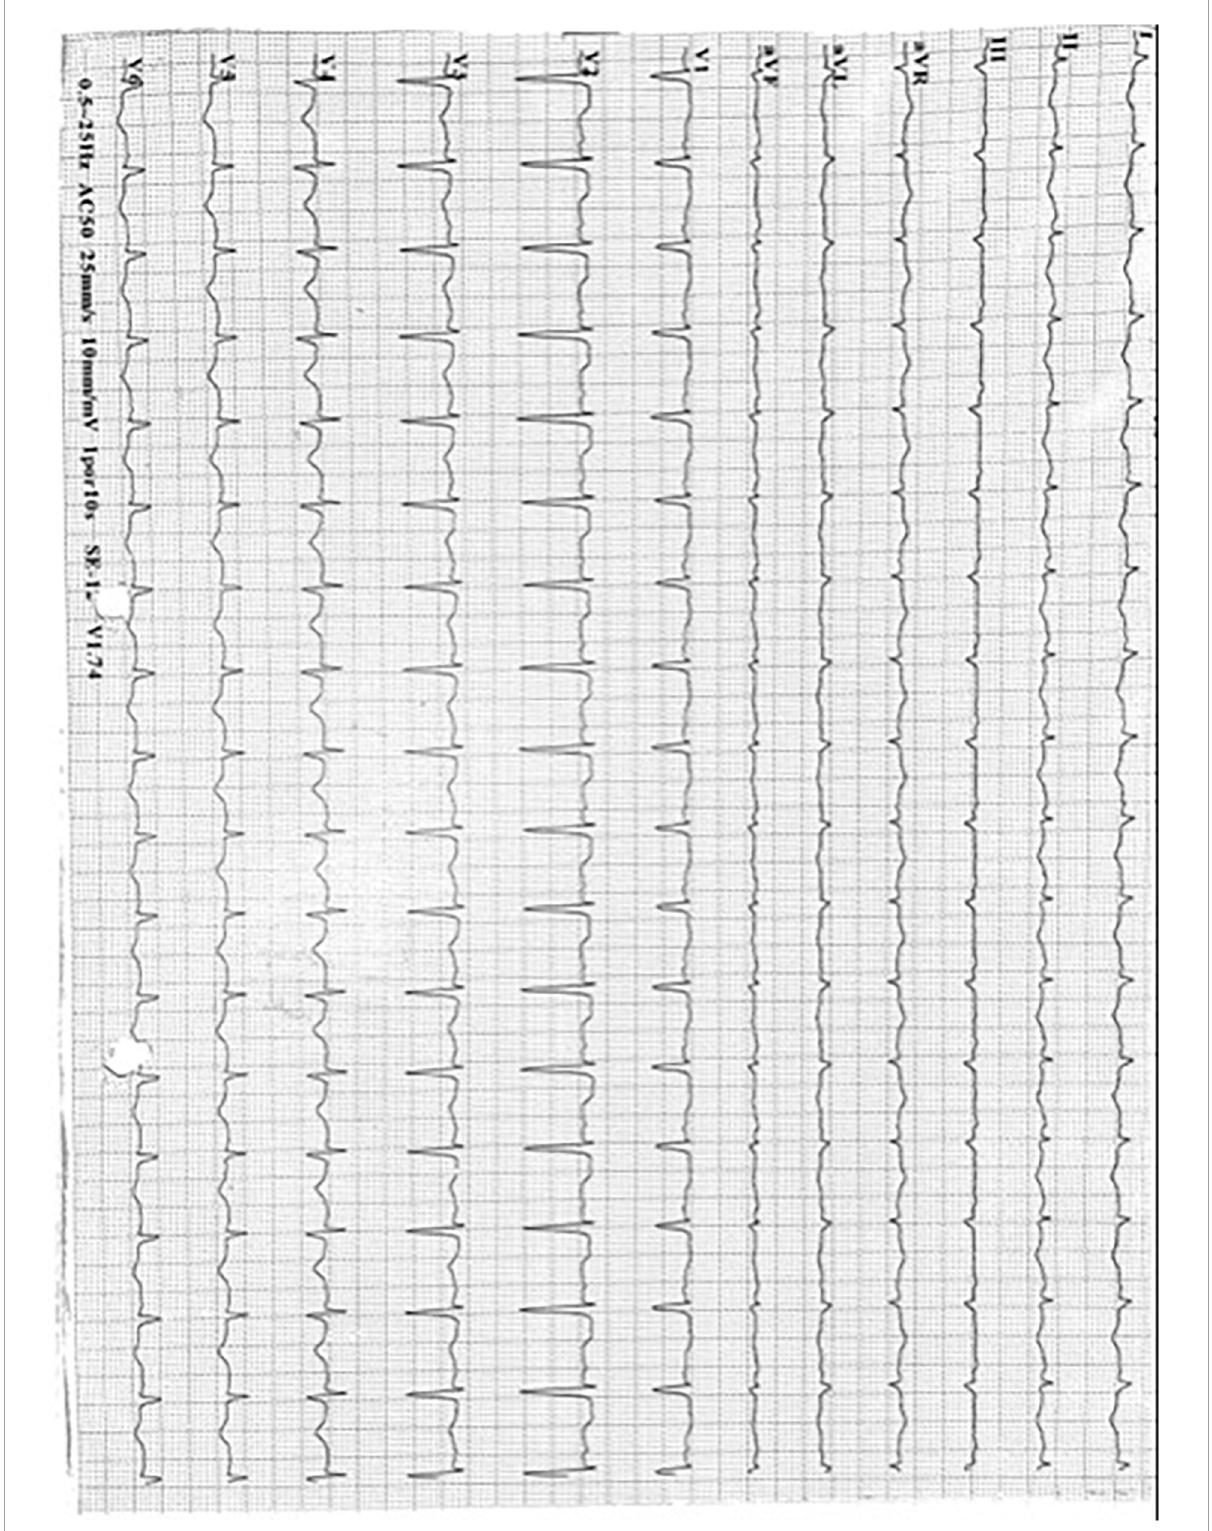
FIGURE1 Electrocardiogram series. Shows the electrocardiogram at TTS diagnosis ST segment elevation in anterior and septal walls (V2 and V3), with symmetrical T wave inversion in all anterior segments (DI, aVL, v4 to V6), and prolonged corrected QT interval (more than 500